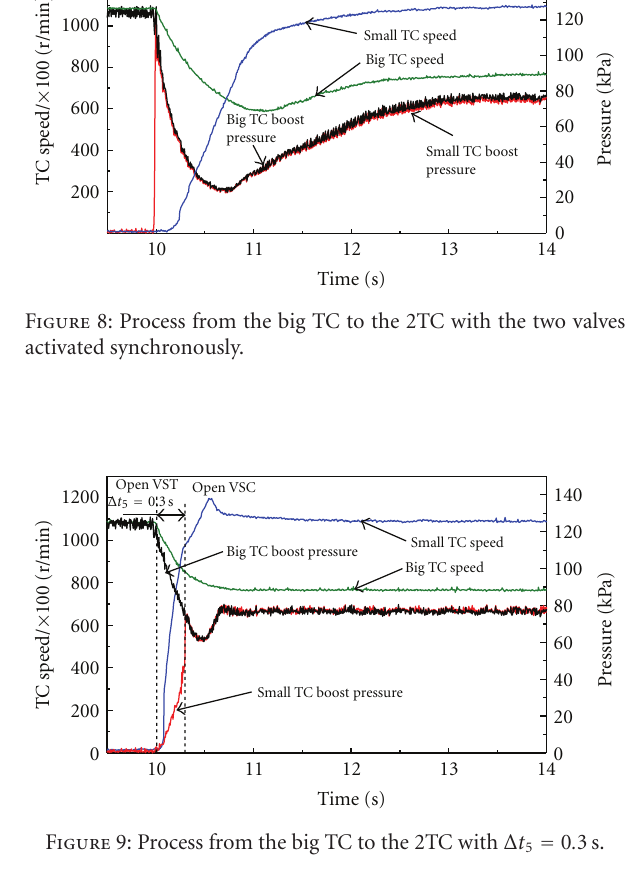
defined as the reference timing, and then VSC is closed Δ t 6 s later. The experimental results show that when Δ t 6 = 0 . 3 s, the small compressor does not surge (shown in Figure